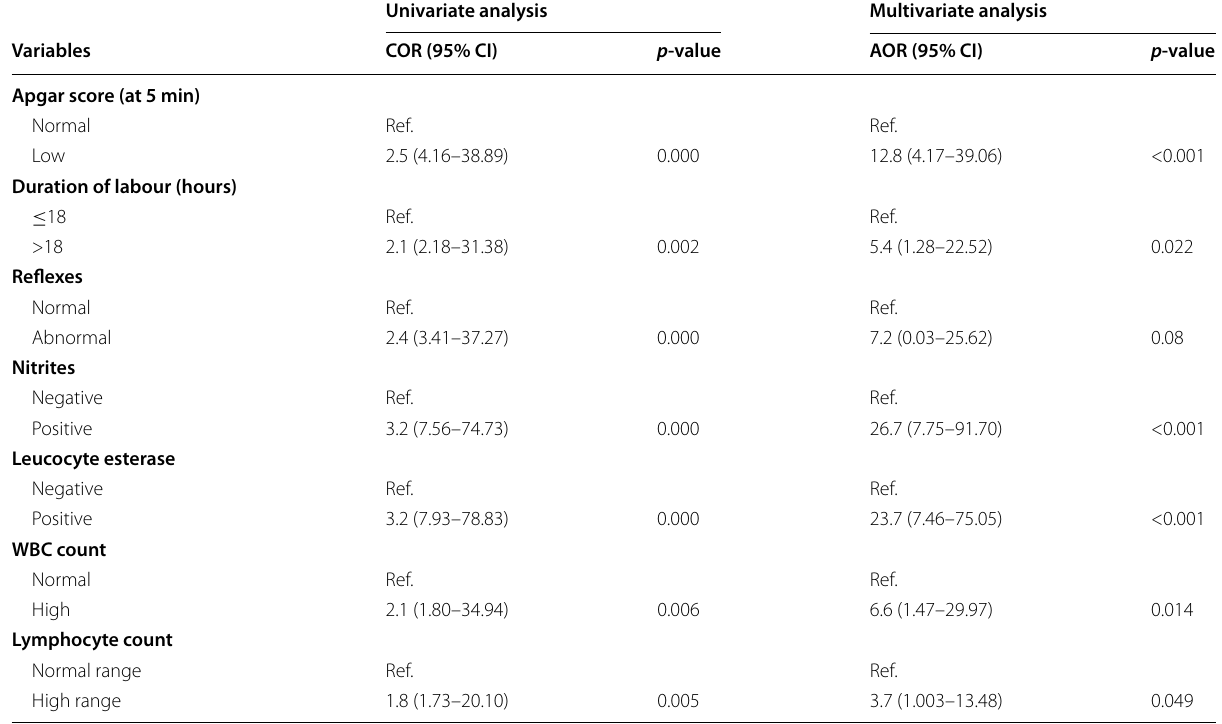
Table 3 Predictors of urinary tract infection (UTI) among neonates ( N